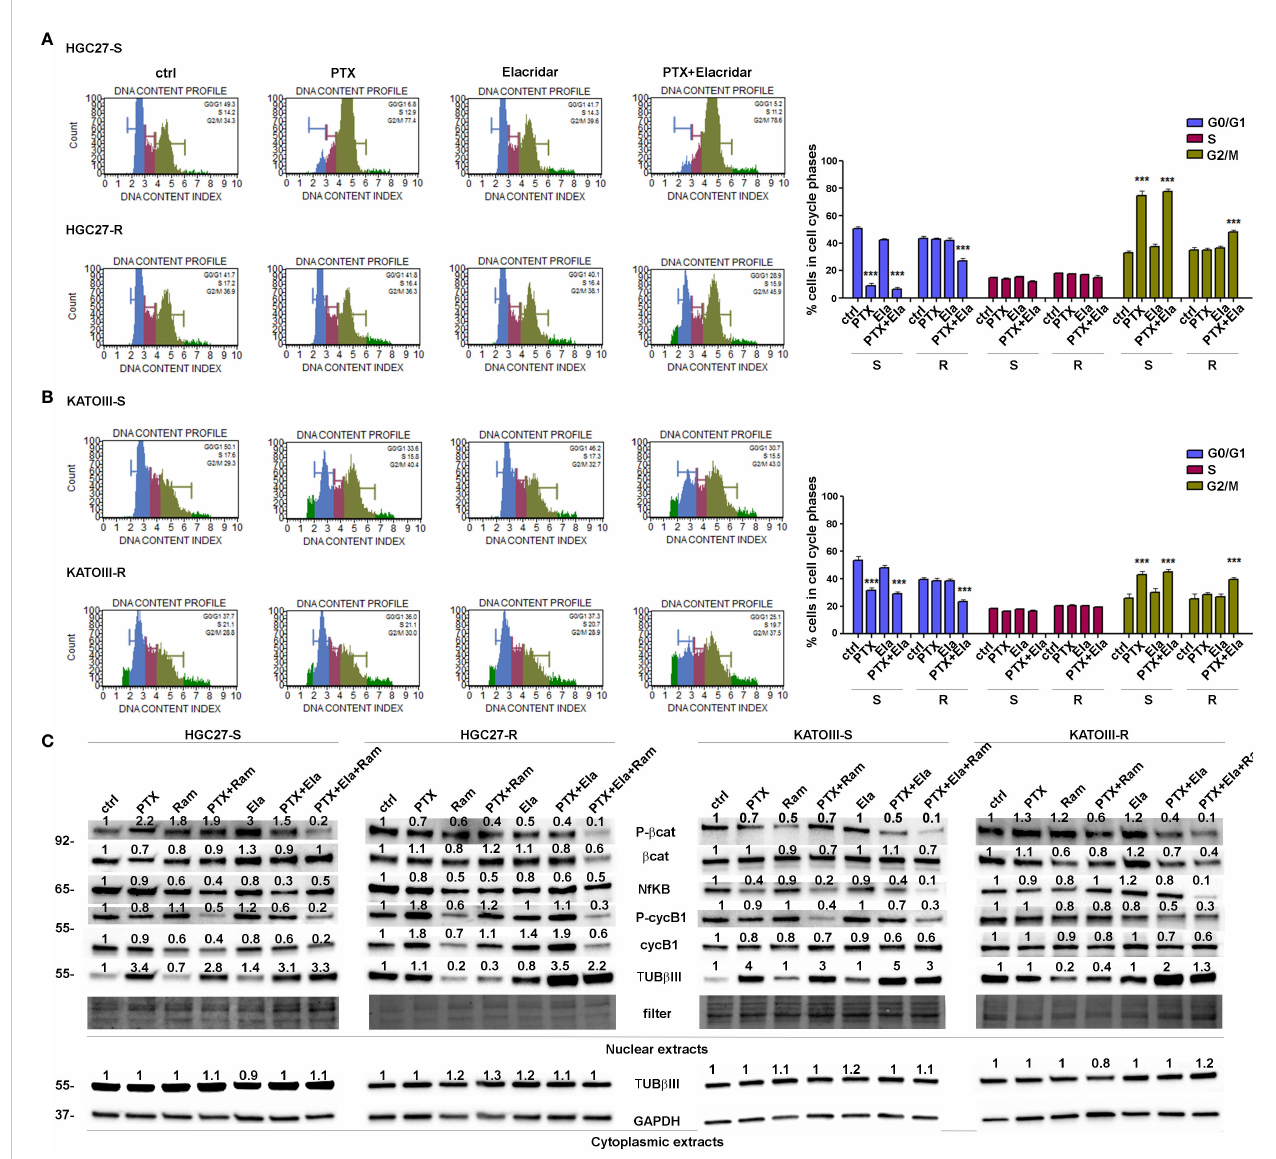
FIGURE 3 Effects of PTX, Ram and Ela on cell cycle progression in GC cell lines. HGC27-S, HGC27-R (A) and KATOIII-S, KATOIII-R (B) human GC cells were treated with/without 4 nM (HGC27) or 2 nM PTX (KATOIII) and 100 nM Ela alone or in combination for 12 hrs. The percentage of cells in each cell cycle phase characterized by different DNA content index (blue for G0/G1 phase, magenta for S phase and green for G2/M phase) were shown in representative DNA content pro fi les. Apoptotic cells in sub-G1 (on the left end) or small aggregates of cells (on the right end) were indicated in bright green. The percentage of cells in G0/G1, S and G2/M phases was evaluated for both HGC27 S/R and KATOIII S/R, and plotted in the relative graphs. The results were relative to three independent experiments, expressed as mean ± SD. In each cell cycle phase, statistical analysis was assessed comparing the values obtained in each experimental condition to those of corresponding untreated cells, ***p<0.001. (C) Representative Western Blotting analysis performed in HGC27-S/ R and KATOIII-S/R cells relative to the nuclear expression of activated b -catenin, NFkB, Cyclin B1 and TUBbIII and cytoplasmic expression of TUBbIII after 48 hrs of PTX, Ram and Ela single or combined treatments. Nuclear protein extracts have been normalized using stain free technology. GAPDH has been used as a normalizer of cytoplasmic protein extracts. Values indicating normalized expression levels are shown on each